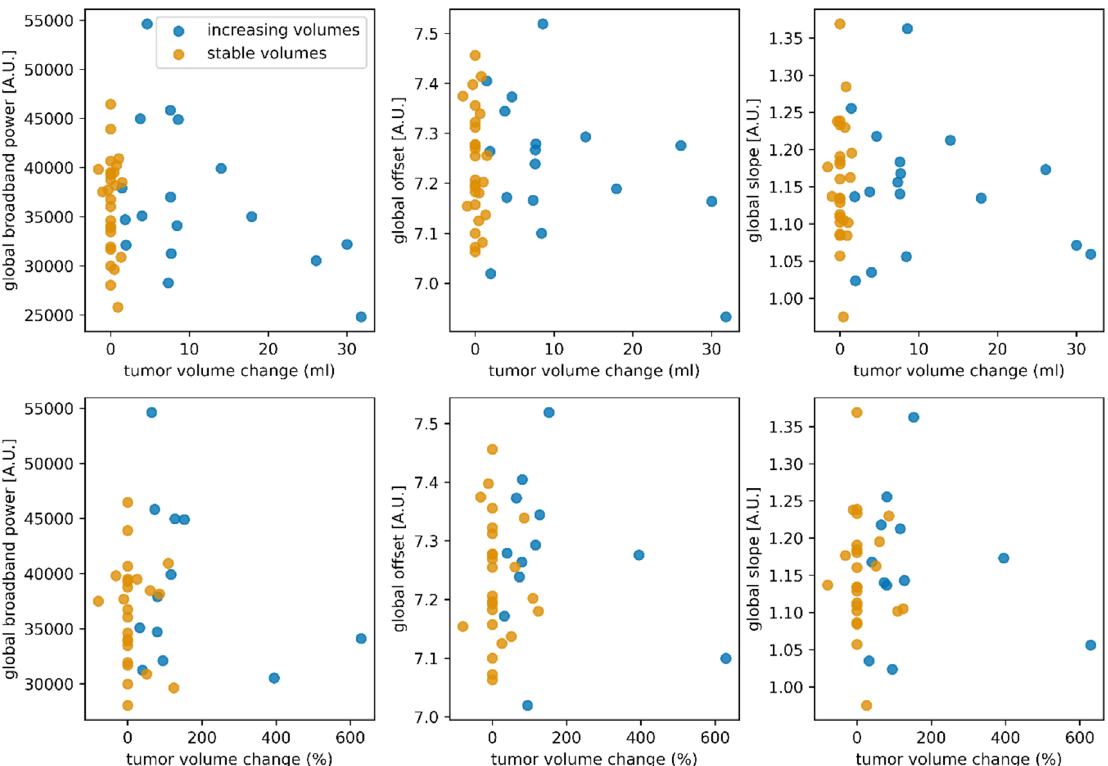
Figure 2. Correlations between tumor volume changes and global brain activity. No significant correlations were found between brain activity and tumor volume change expressed in ml (upper panels) or percent tumor volume change (lower panels) after correction for the three associations between brain activity (broadband power, offset, slope) tested per change score type (ml and percentage). In eight patients, it was not possible to compute percent change, because the initial tumor volume was 0 ml. A.U. arbitrary units.